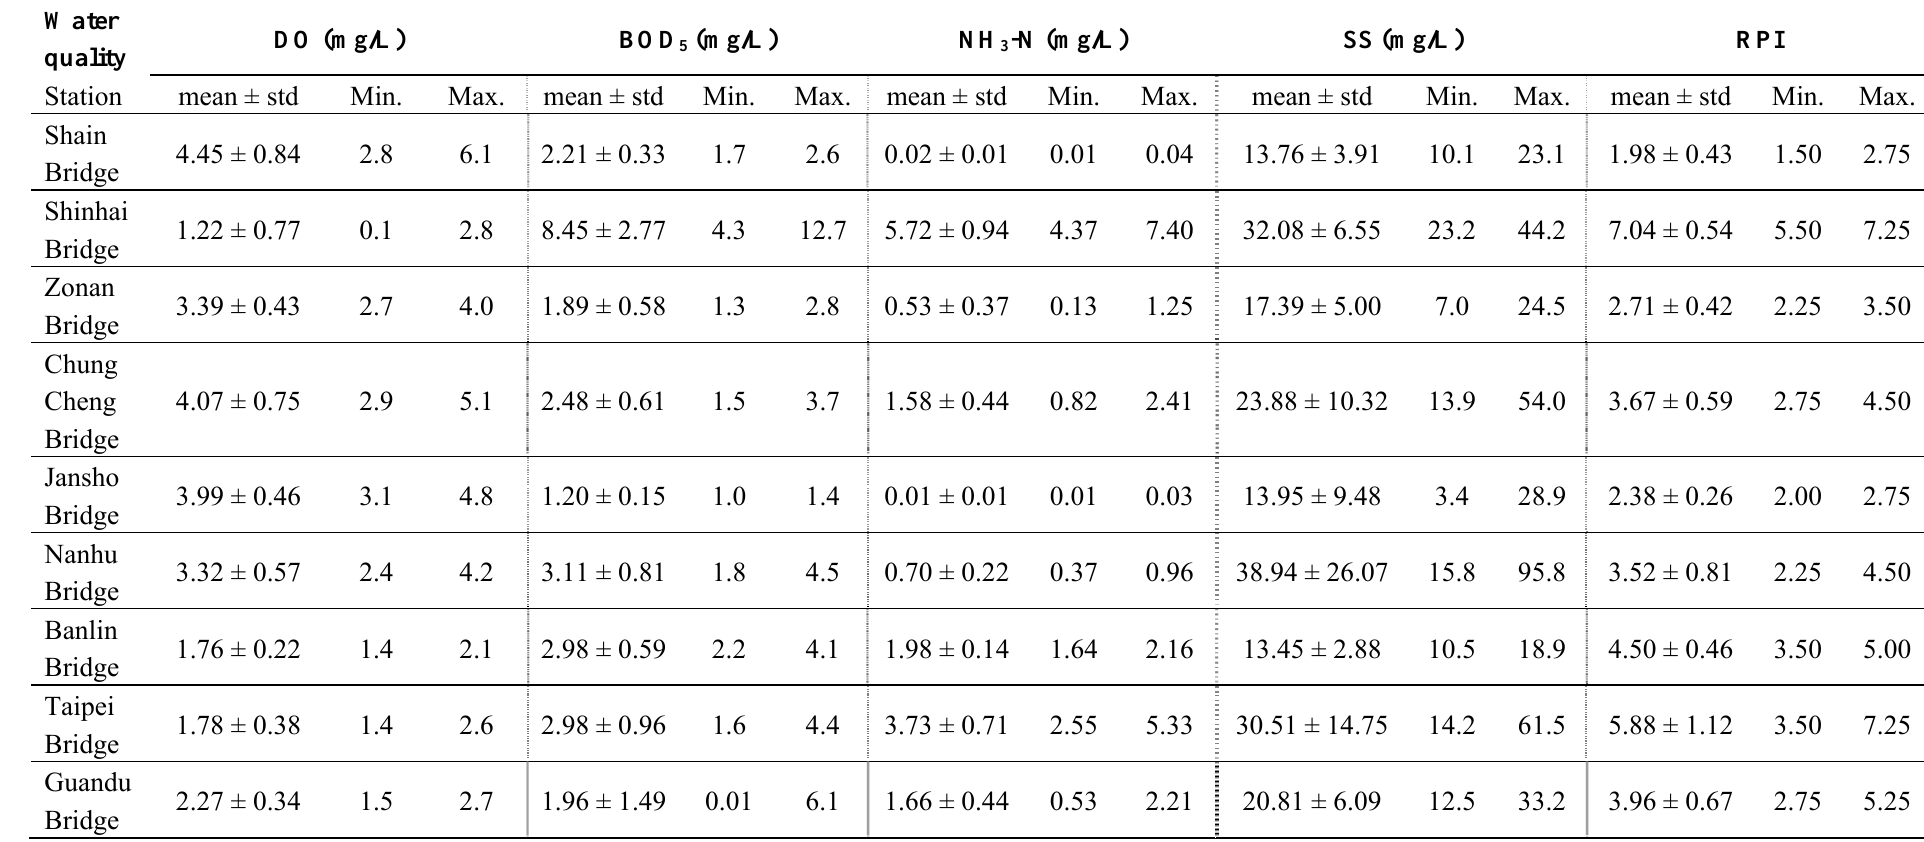
Table 2. Results of water quality sampled from nine sites and their computed RPI